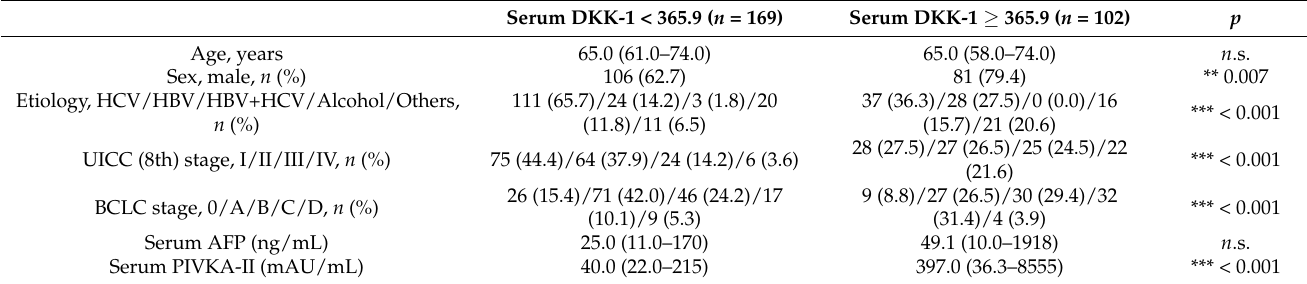
Table 3. Characteristics of patients in the groups with serum DKK-1 < 365.9 and ≥ 365.9 pg/mL.